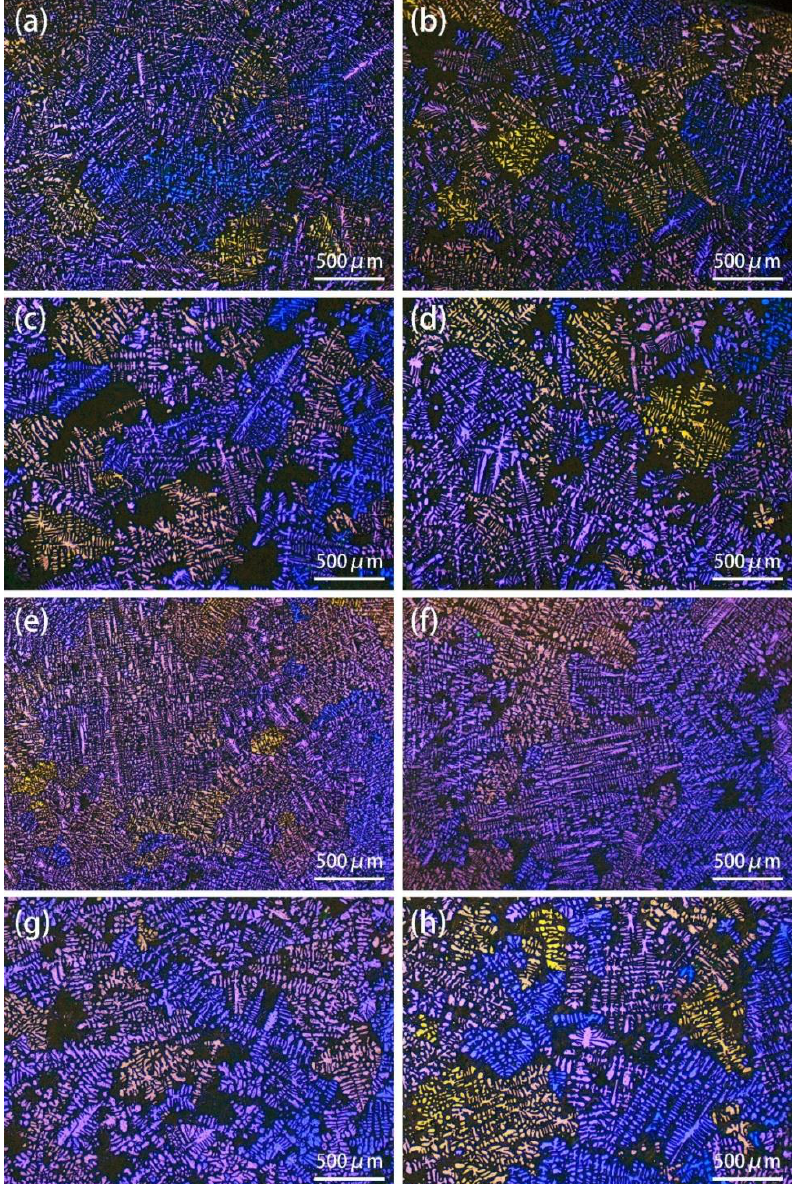
Figure 2. OM microstructure of α-Al in Al-8Si alloys under different cooling rates: ( a ) Sr + 234 °C/s, ( b ) Sr + 136 °C/s, ( c ) Sr + 63.2 °C/s, ( d ) Sr + 46.2 °C/s, ( e ) 234 °C/s, ( f ) 136 °C/s, ( g ) 63.2 °C/s, ( h ) 46.2 °C/s.